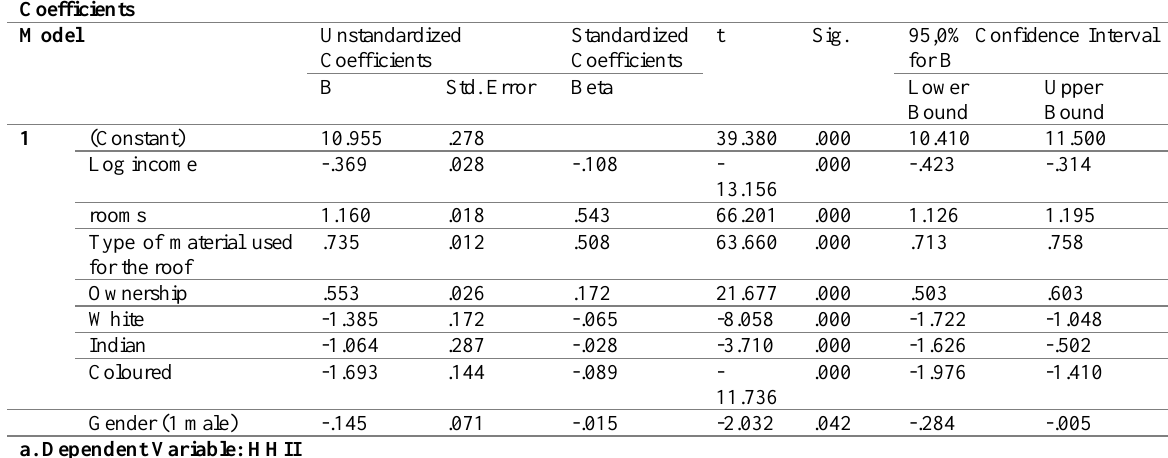
Table 5: Regression